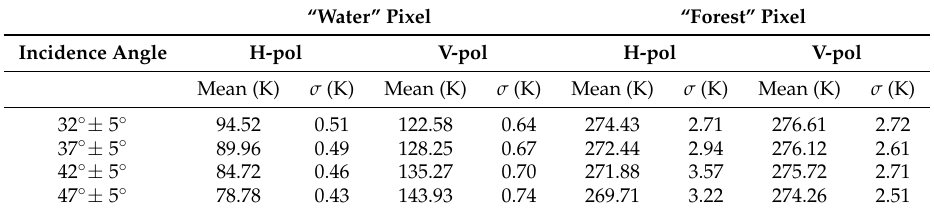
Table 2. Average and standard deviation ( σ ) of the TB over the “water” and “forest” pixel in both